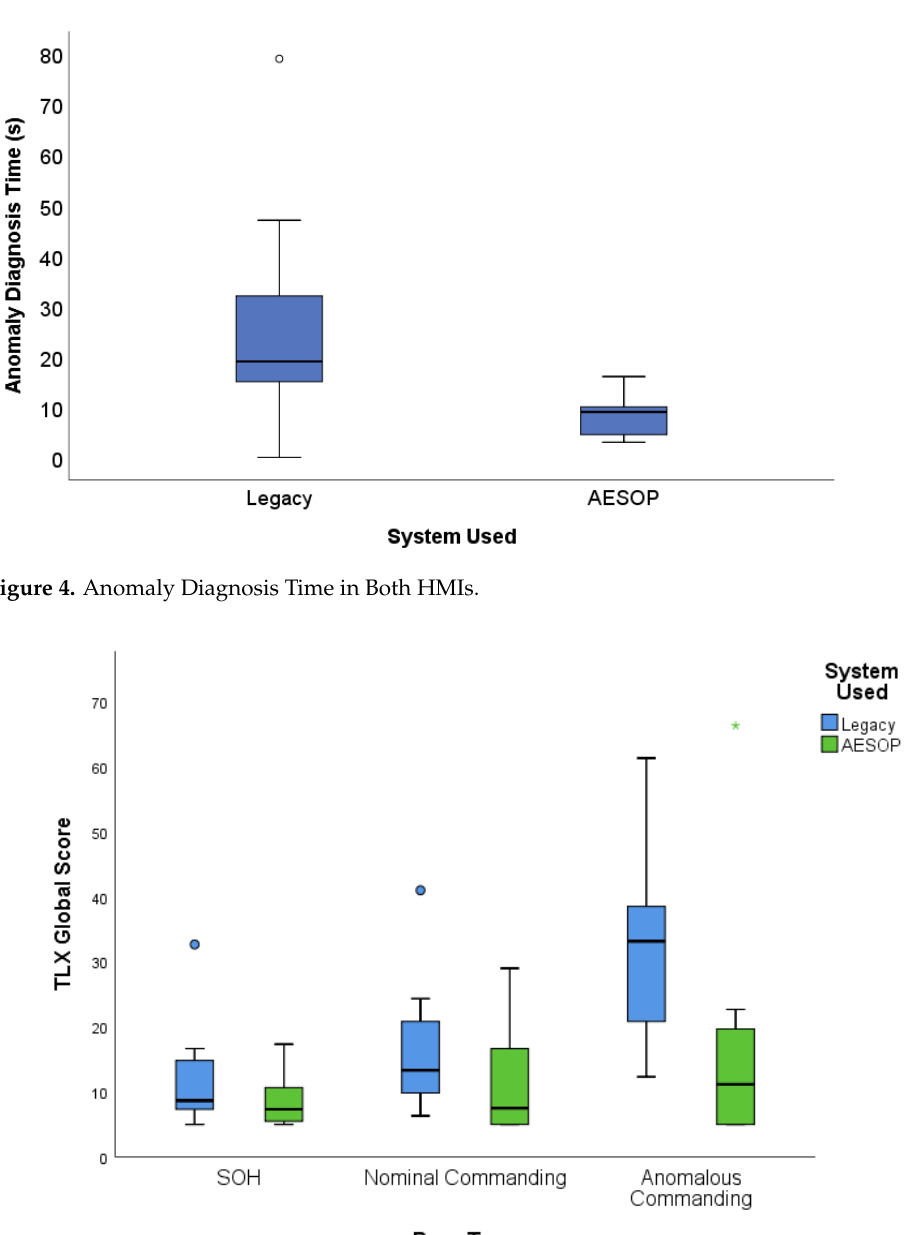
Figure 5. Workload Level for both HMIs across Pass Types. Outliers are shown as dots (when in excess of two SDs) or as an asterisk (when in excess of three SDs). (when in excess of two SDs) or as an asterisk (when in excess of three Table 4. Descriptive Statistics and Means Testing for Workload on All HMIs and Pass Types.